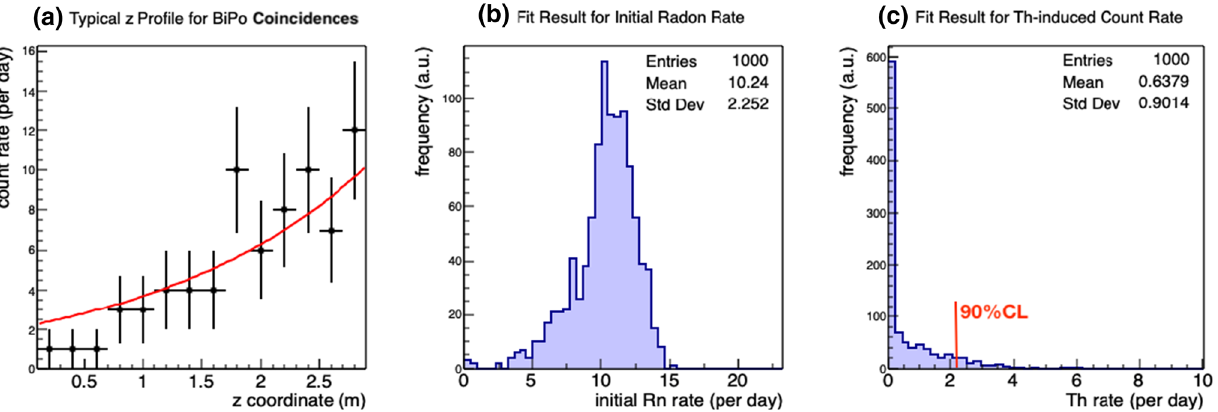
Fig. 19 Th-rate determination in continuous-mode operation, assum- ing 830 initial Rn counts per day and AV volume. The time-dependence of the 220 Rn decay rate is mapped on the reconstructed Bi–Po vertex